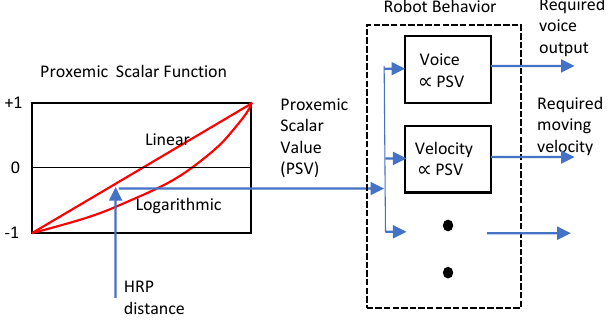
Figure 13. The method proposed in [80] to adapt a robot’s behavior based on HRP.